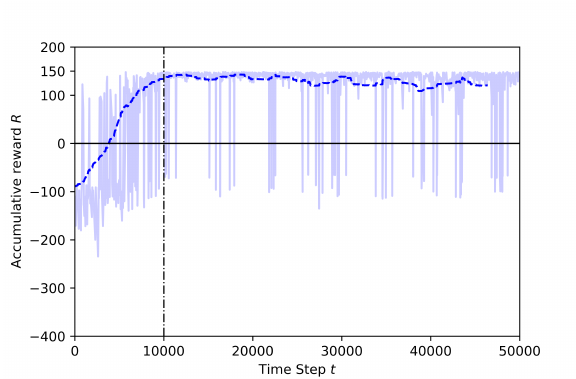
Figure 19. Training result for Case 2.2 by Transfer Learning.